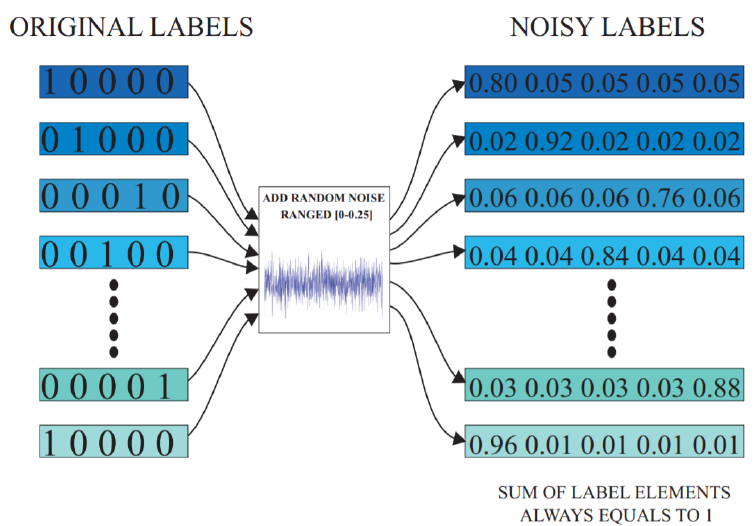
Figure 2. Illustrative explanation of the noisy label